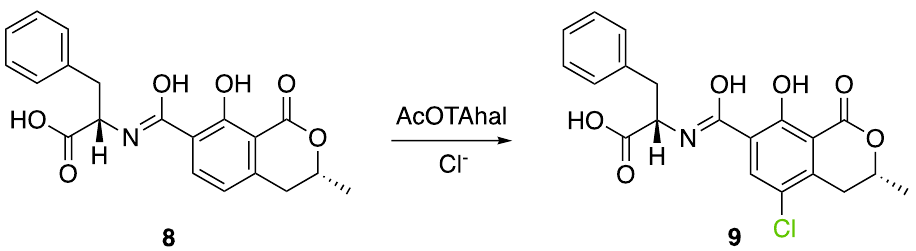
Figure 13. The FDH AcOTAhal catalyzes the chlorination of ochratoxin B ( 8 ) to form ochratoxin A ( 9 ) in Aspergillus carbonarius [33].